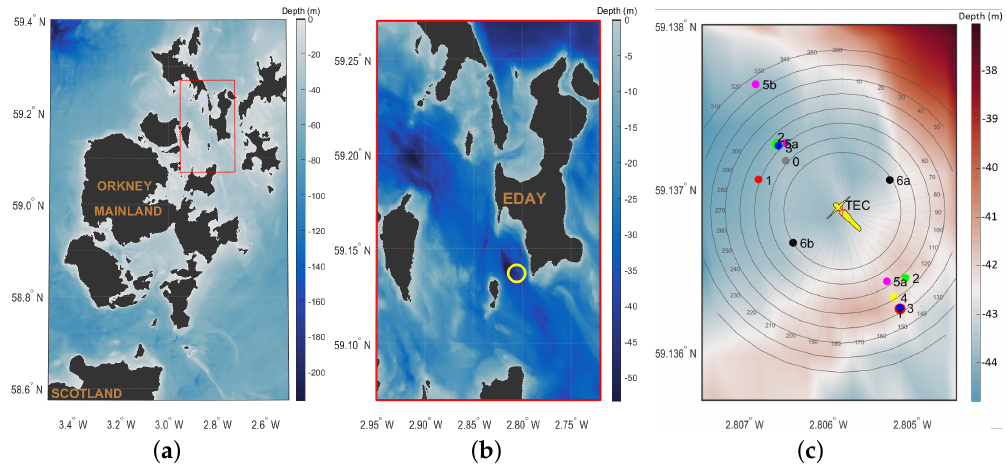
Figure 1. Maps showing bathymetry and coastlines for ( a ) the Orkney Islands, Scotland, and the location of the European Marine Energy Centre (EMEC) tidal energy test site (red rectangle). In ( b ), the region of the test site is expanded, and the deployment location of the TEC and multiple Diverging-beam Acoustic Doppler Profilers (D-ADP) deployments are identified as a yellow circle and further detailed in ( c ), where range rings (grey circles) commence at a radius of 40 m from TEC and increment every 10 m. ( a ) The Orkney Islands; ( b ) the EMEC tidal test site; ( c ) D-ADP deployments.